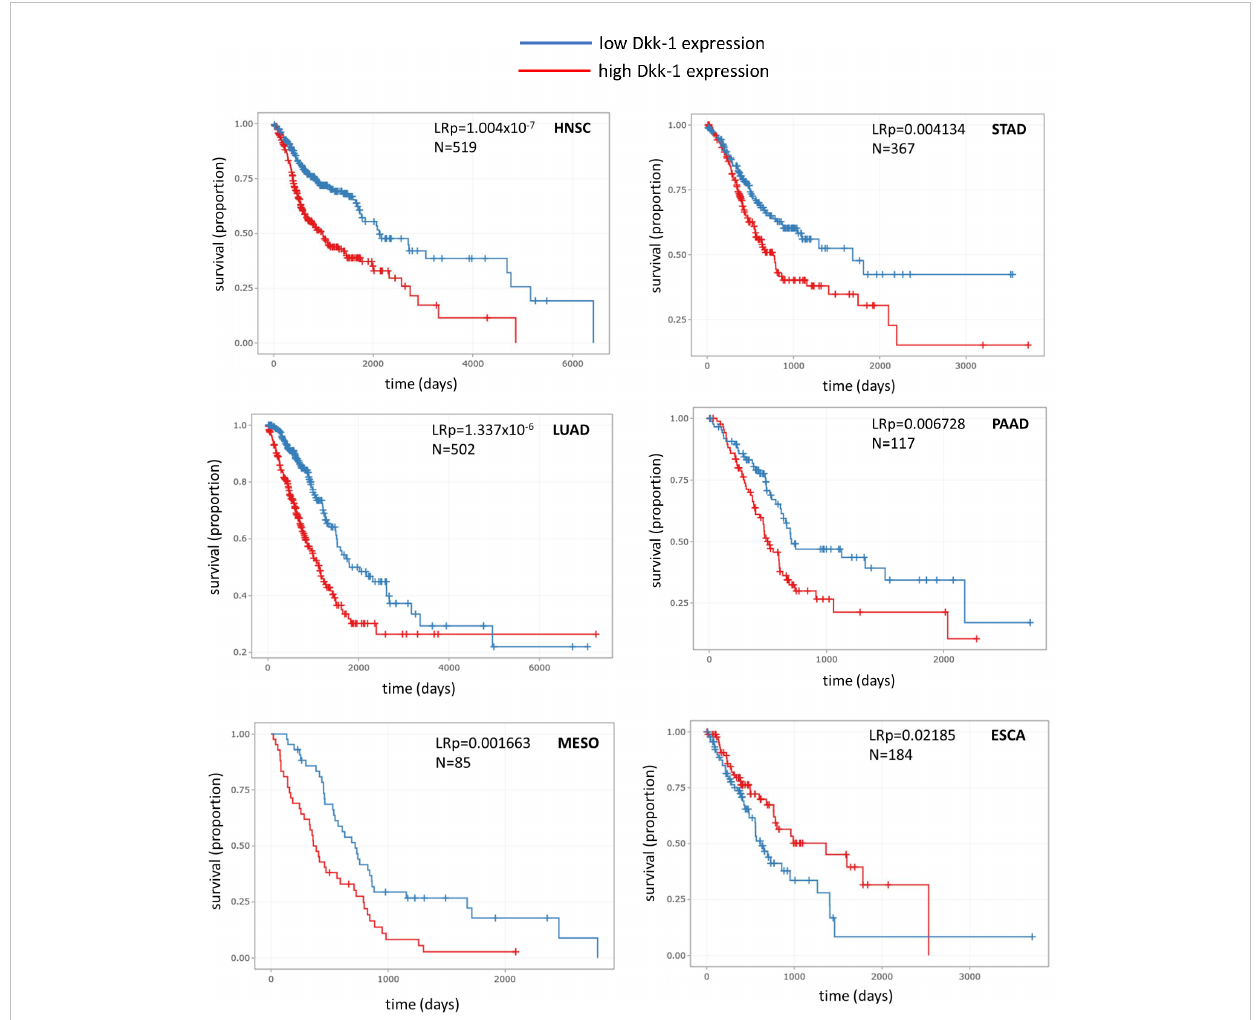
FIGURE 2 Kaplan-Meier survival plots for various tumor types where Dkk-1 has high or low transcriptional status (de fi ned as above or below the mean value for the dataset respectively). HNSC, head and neck squamous cell carcinoma; LUAD, lung adenocarcinoma; MESO, mesothelioma; STAD, stomach adenocarcinoma; PAAD, pancreatic adenocarcinoma; ESCA, esophageal carcinoma. Data were recovered from TGCA and processed by the DrBioright platform. Data were analyzed by log-rank